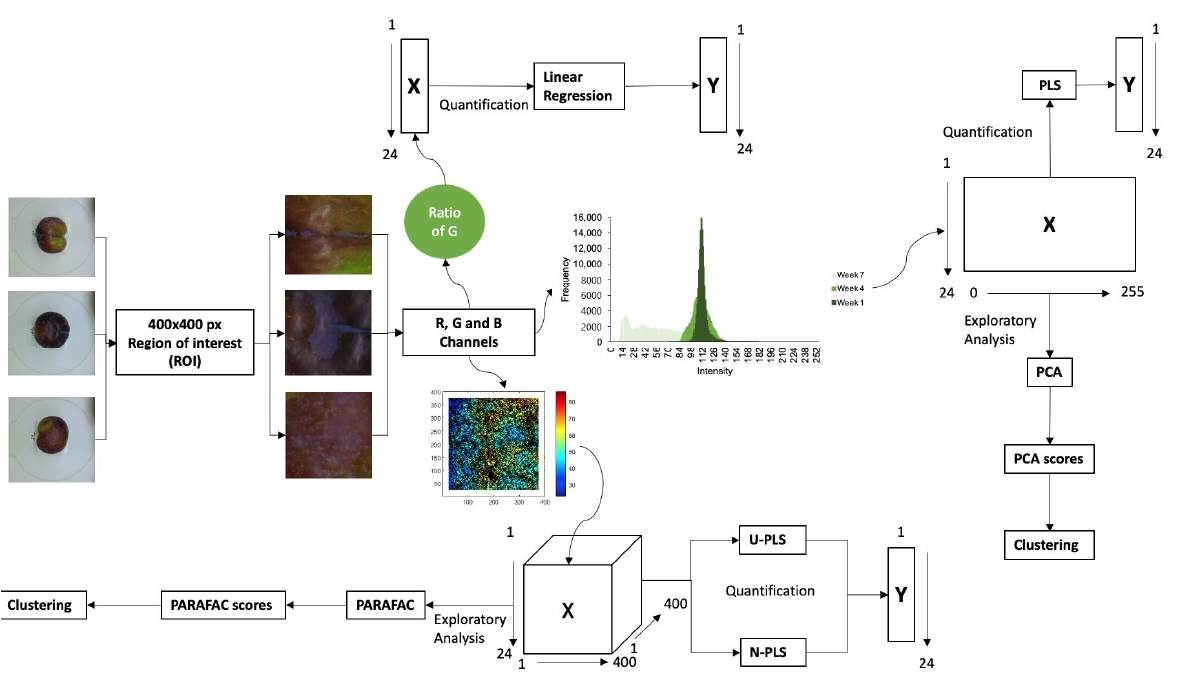
Figure 1. Scheme of the images acquisition and data processing.